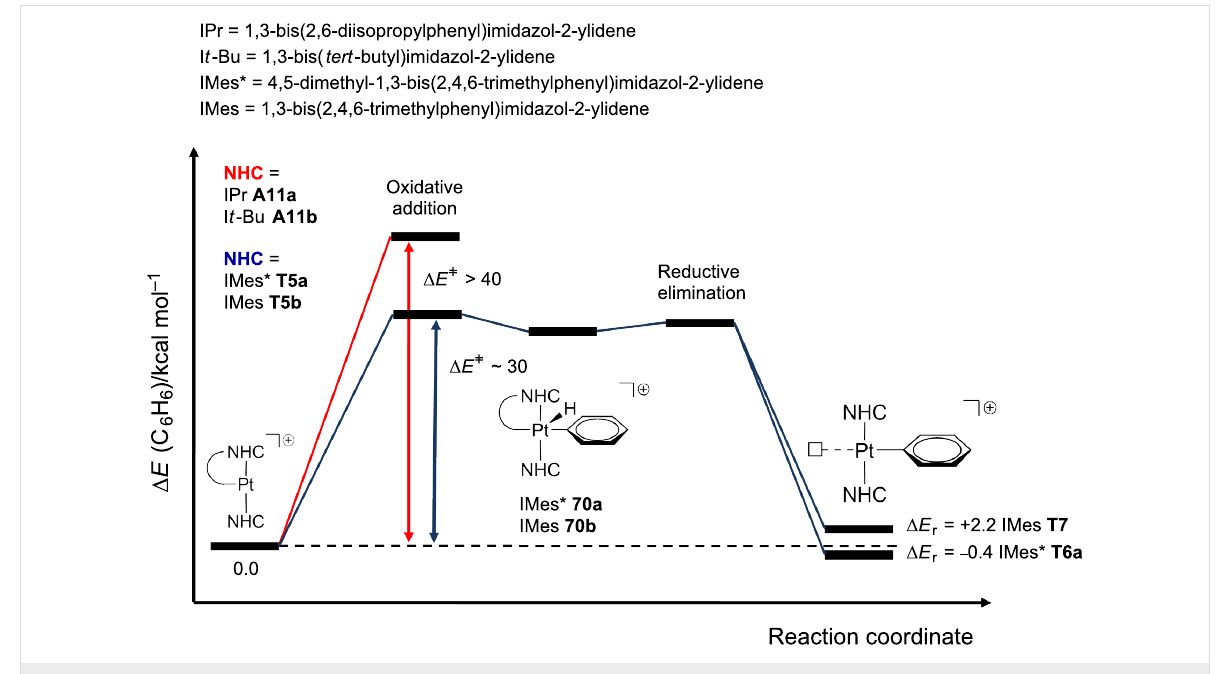
Figure 19: Energy profiles (in benzene solvent) for the benzene C–H bond activation from A11a , A11b , T5a and T5b